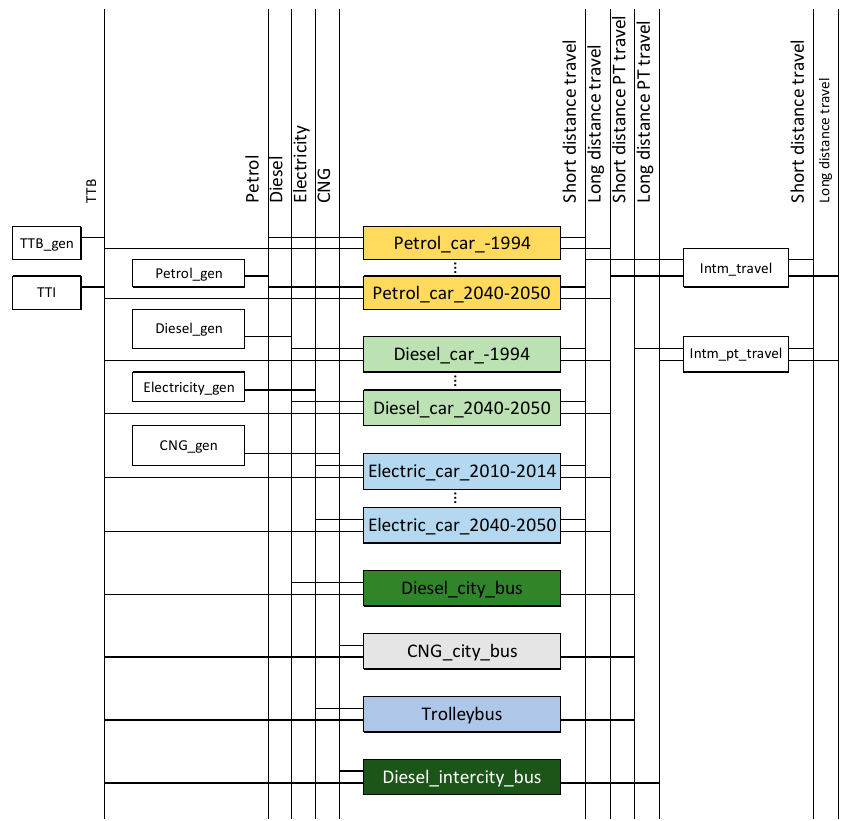
Figure 6. The reference scheme of the proposed modeling approach for the passenger transport sector.